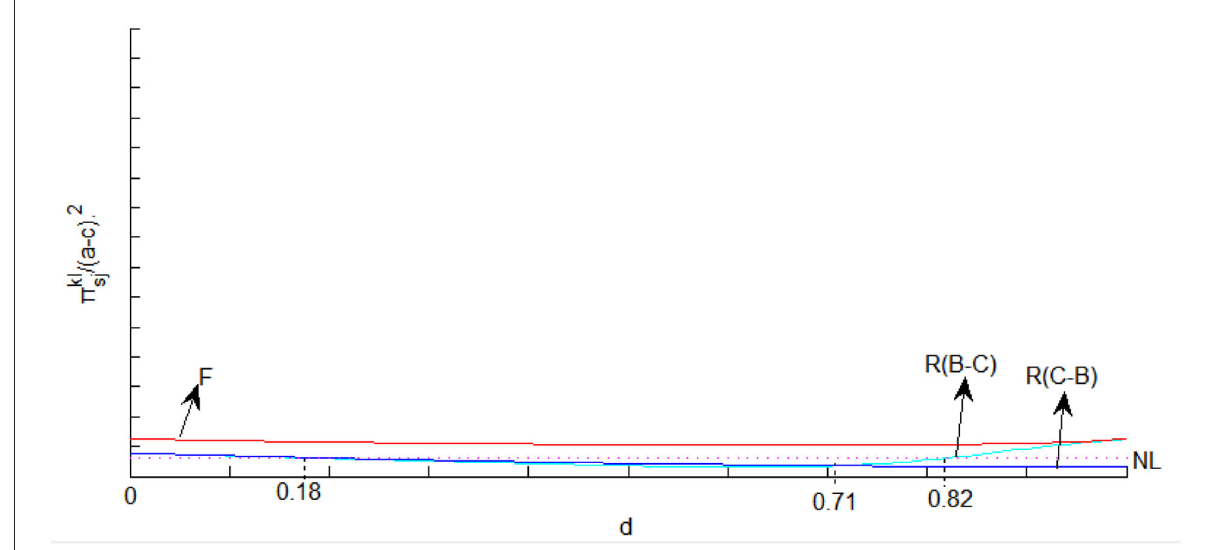
FIGURE2 The profits of the supplier in different licensing methods under mixed competition.